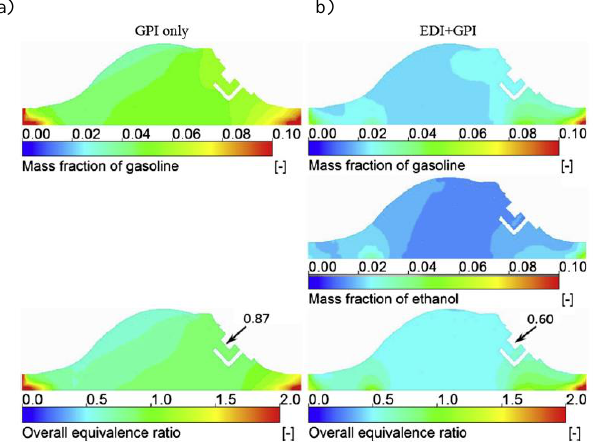
Fig. 6. Distribution of gasoline and ethanol mass (a) in the combustion cham- ber, and the excess air coefficient (b) when supplying the engine with gasoline (GPI) and ethanol with gasoline (EDI + GPI) (reproduced from [19])